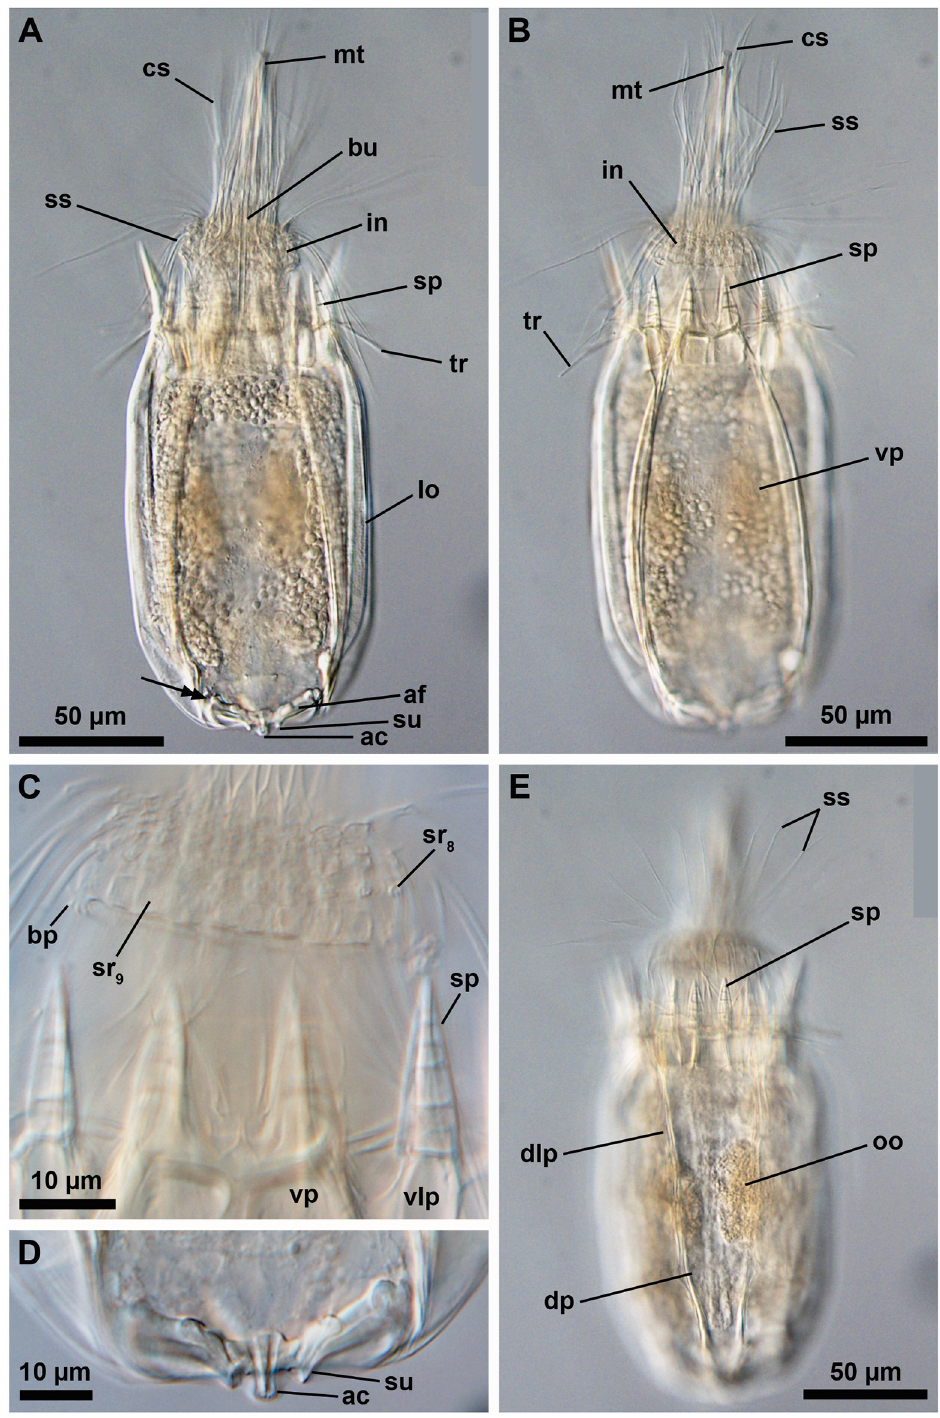
Fig 15. Light micrographs of the holotypic adult female of Scutiloricus hugoi gen. et sp. nov. Anterior faces up in all aspects. (A) Overview of the extended specimen, with focus on the internal buccal tube (bu). Double-headed arrow points to large pores (gland outlets?) situated on the posterior region of the ventral plate. (B) Ventral view of the specimen. (C) Close-up of the introvert, neck and anterior region of the lorica, ventral view. Note the fenestrated aspect of the anterior spikes (sp). (D) Close-up of the anal field. (E) Dorsal view of the extended specimen. Abbreviations: ac, anal cone; af, anal field; bp, basal plate; cs, clavoscalid; dlp, dorsolateral plate; dp, dorsal plate; in, introvert; lo, lorica; mt, mouth tube; oo, oocyte; sp, anterior spike; sr 8/9 , spinoscalids of 8 th or 9 th row; ss spinoscalid; su, anal field spurs tr, trichoscalid; vlp, ventrolateral plate; vp, ventral plate.